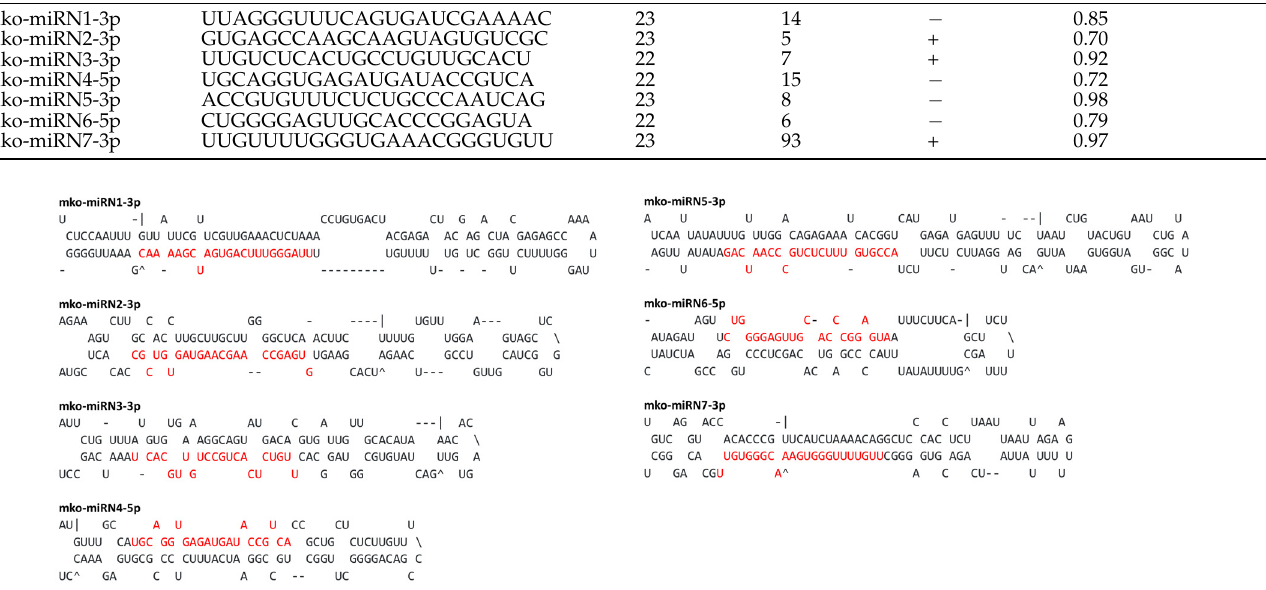
Figure 3. Secondary structures (stem-loops) of M. koenigii novel miRNA precursors. Mature miRNAs are highlighted in red font.